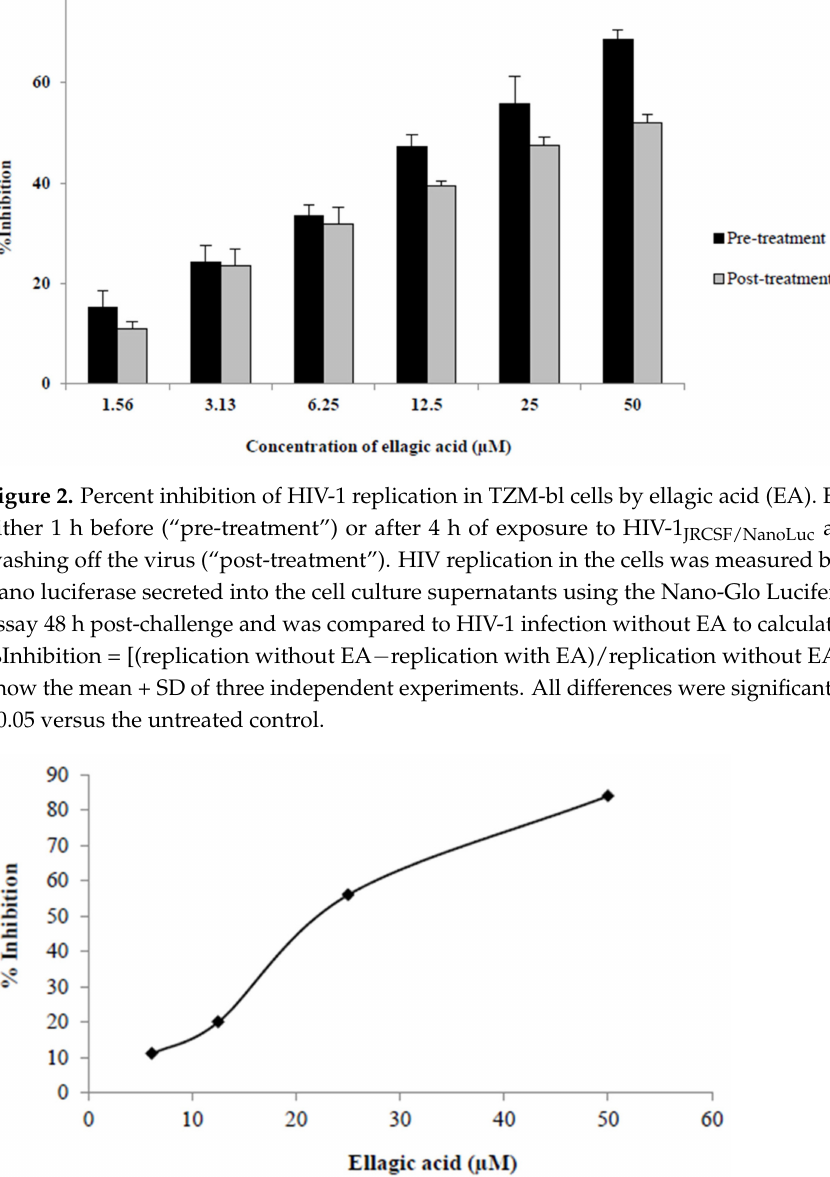
Figure 3. Percent inhibition of HIV-1 replication in U87CD4.CCR5 cells by ellagic acid (EA) showed a dose-dependent result. Cells were incubated for 24 h, were treated with the indicated concentrations of EA, and were incubated again for an additional hour. Then, the cells were infected with the HIV-1 JRCSF/NanoLuc virus and were incubated for 48 h. HIV replication in the cells was measured by detection of nano luciferase secreted into the cell culture supernatants using the Nano-Glo Luciferase detection assay 48 h post-challenge, and the treated conditions were compared to HIV-1 infection without EA to calculate %Inhibition. %Inhibition = [(replication without EA − replication with EA)/replication without EA] ×